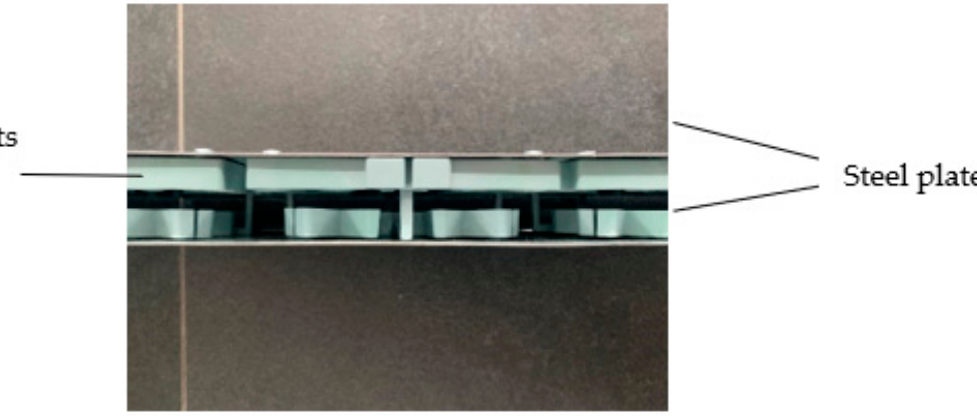
Figure 14. Metasolution with elastic elements in recycled plastic.